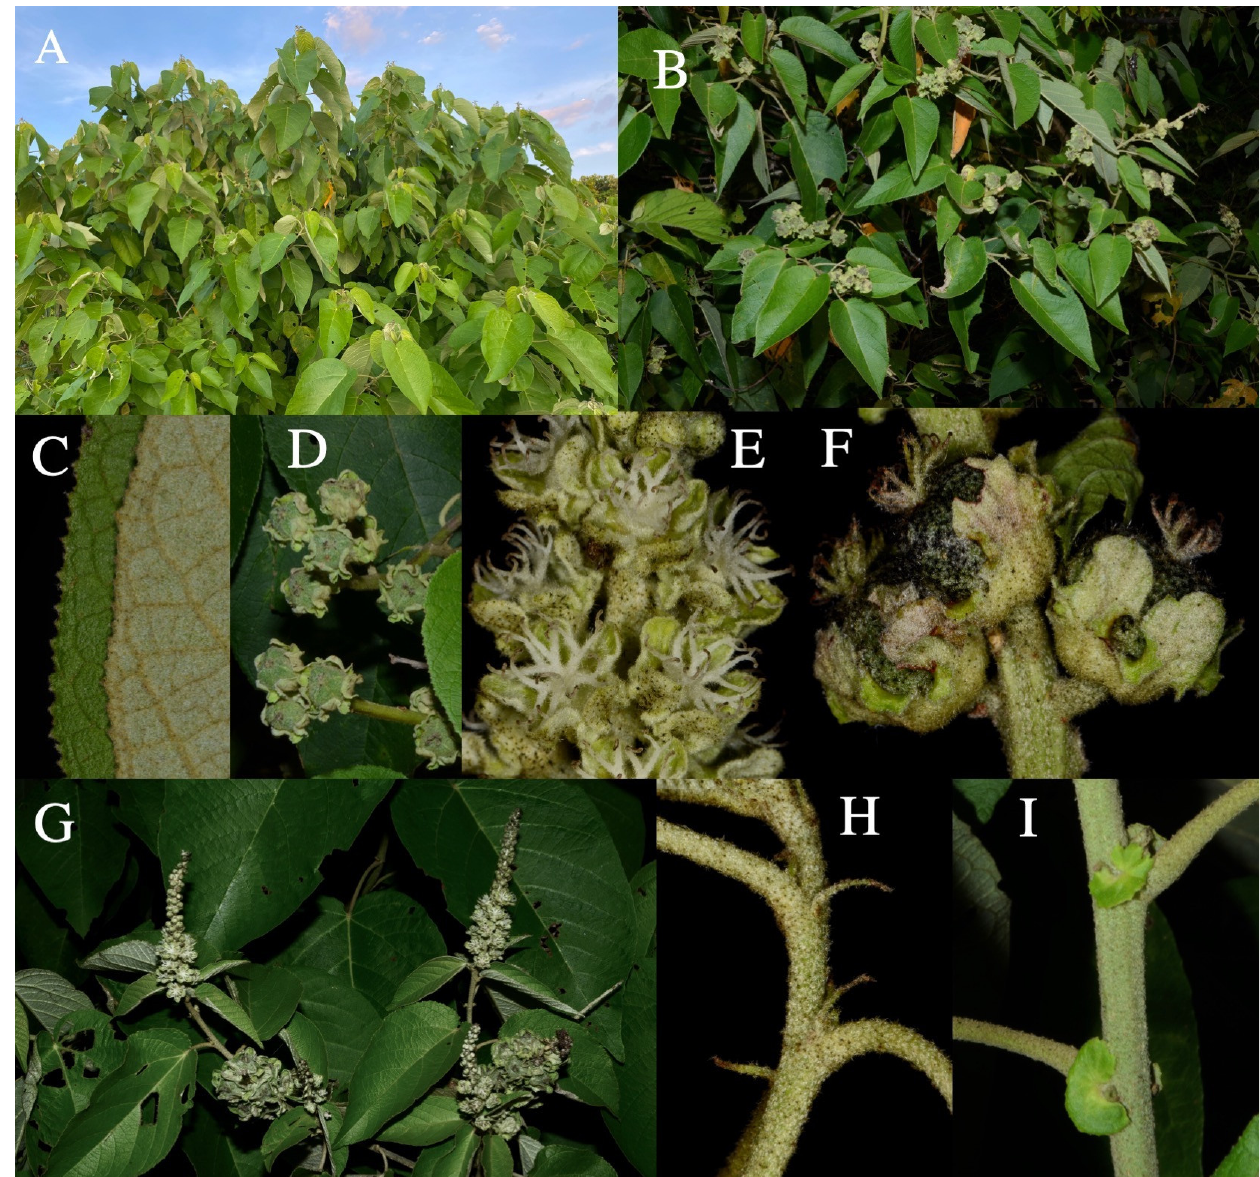
Figure A4. Croton atrostellatus. ( A ) Habit. ( B , G ) Flowering and fruiting branches. ( C ) Upper (left) and lower (right) leaf surfaces. ( D , F ) Fruits. ( E ) Pistillate flowers. ( H ) Subulate stipules. ( I ) Foliaceous